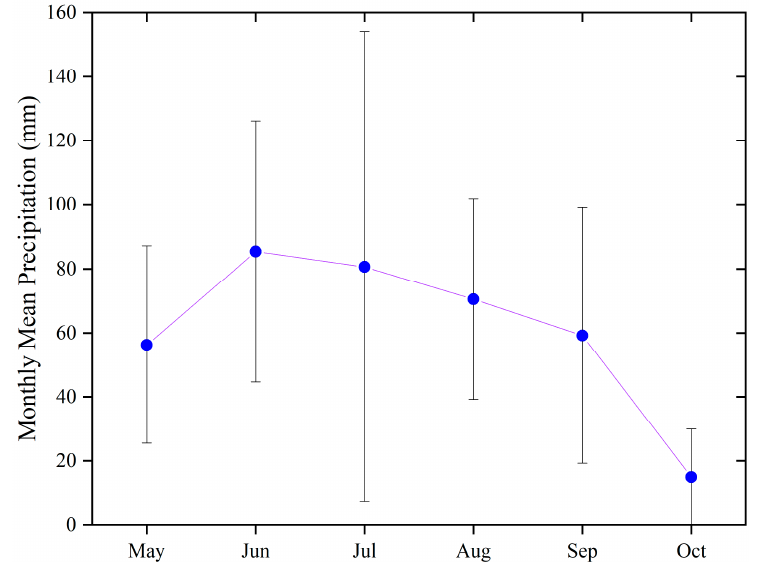
Figure 3. Mean monthly precipitation in the China’s Momoge National Nature Reserve from May to October from 2015 to 2019. Data source: China Meteorological Data Service Center.